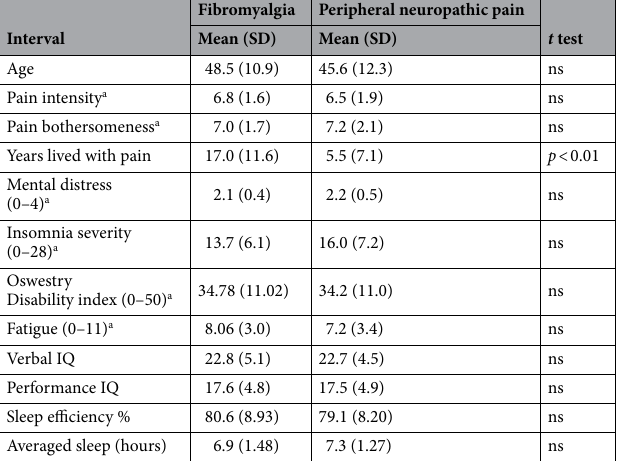
Table 4. Demographics and patient reported outcomes are presented in 73 patients with either Fibromyalgia or Peripheral neuropathic pain (included from 2016–2018). Variables are interval and tested with a t test to determine significant differences between the two pain conditions. a Higher is worse.